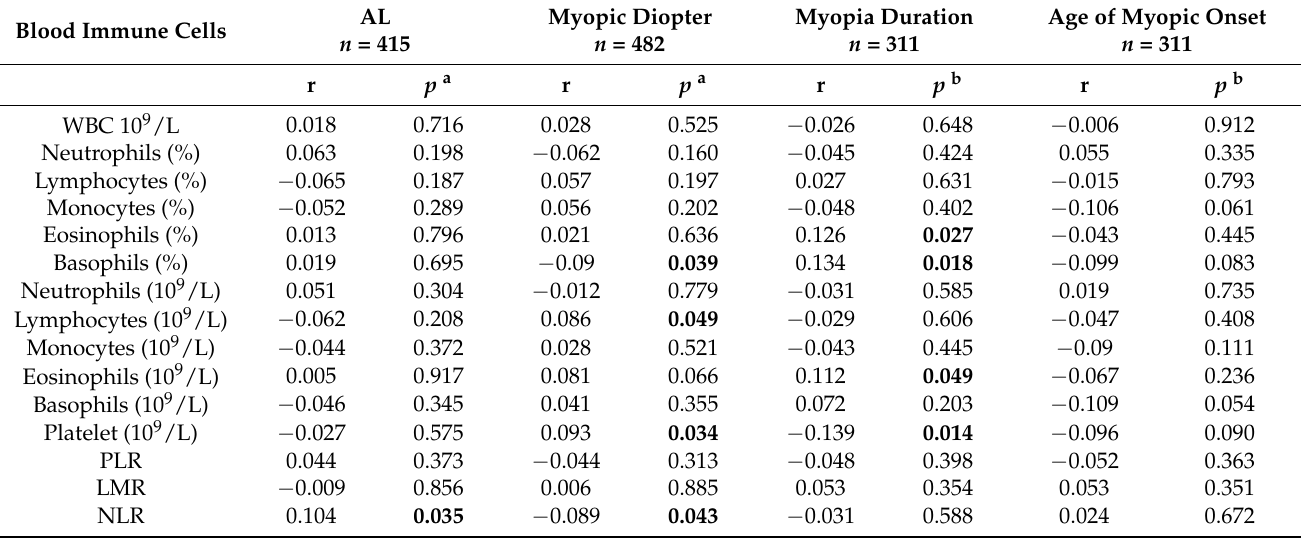
Table 3. Correlations between blood immune cells and myopic